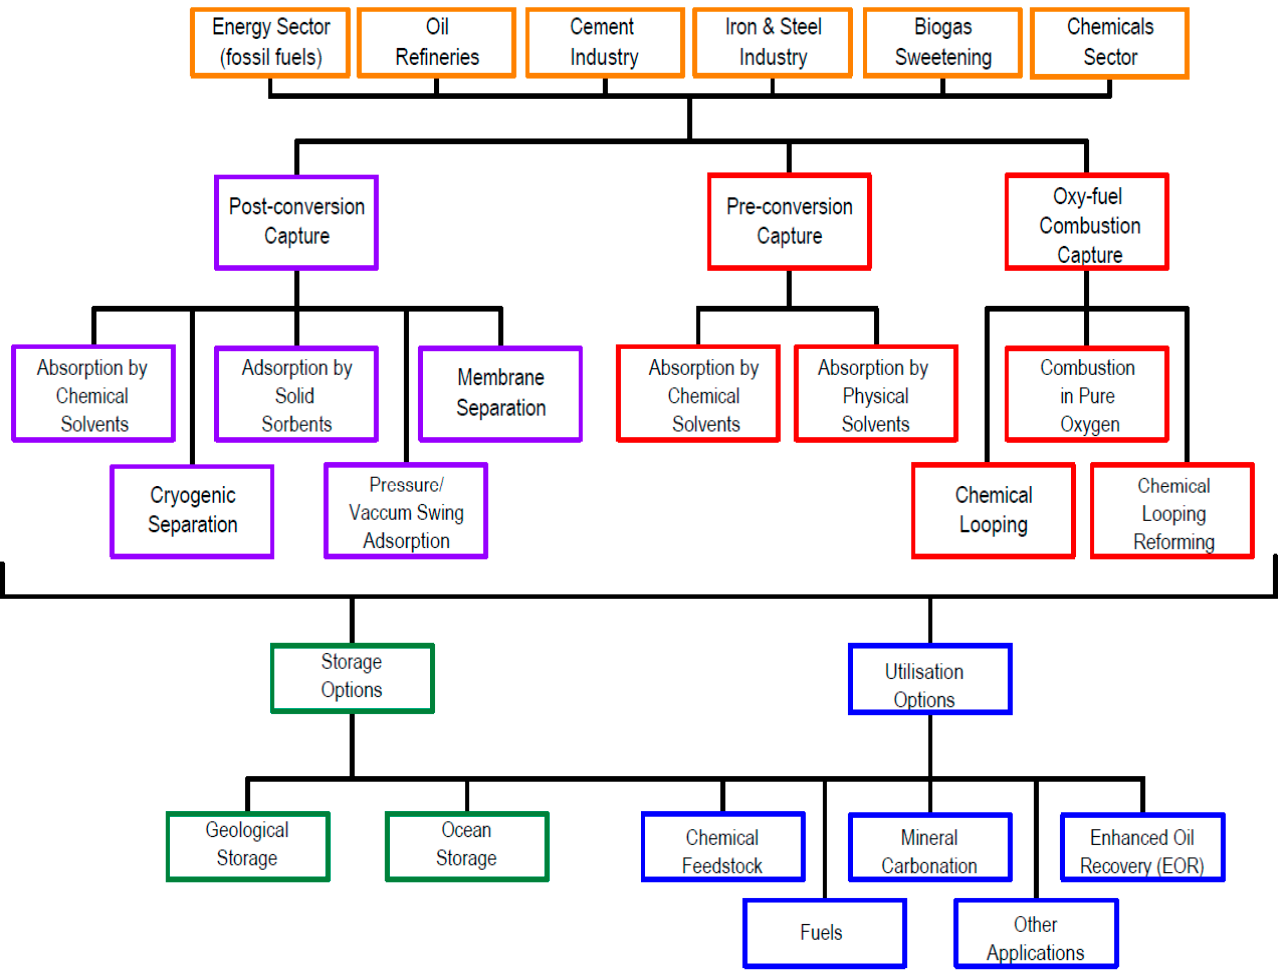
Figure 2. Overview of carbon capture, utilization, and storage options (Adapted from [10]).